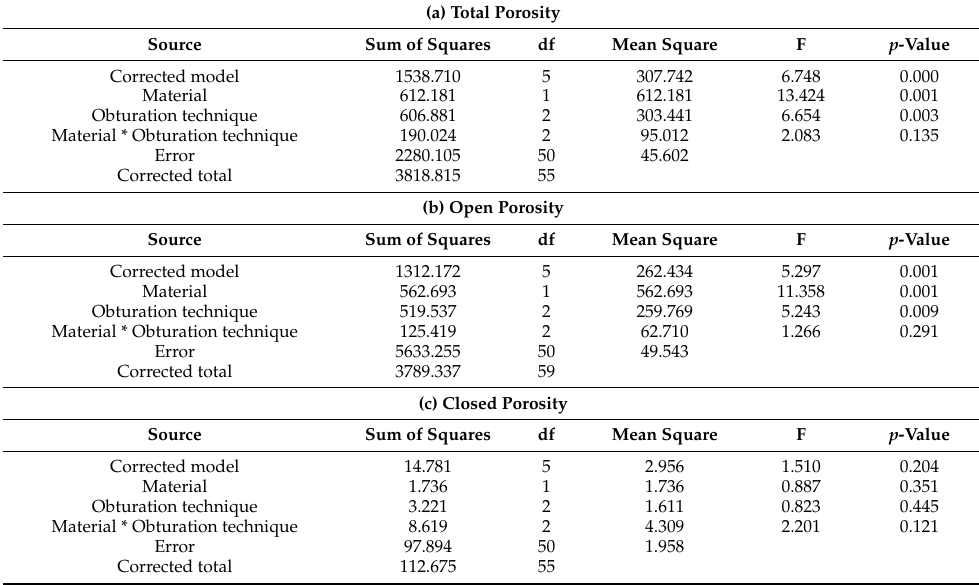
Table 3. Two-way ANOVA considering filling material, obturation technique, and their interaction.